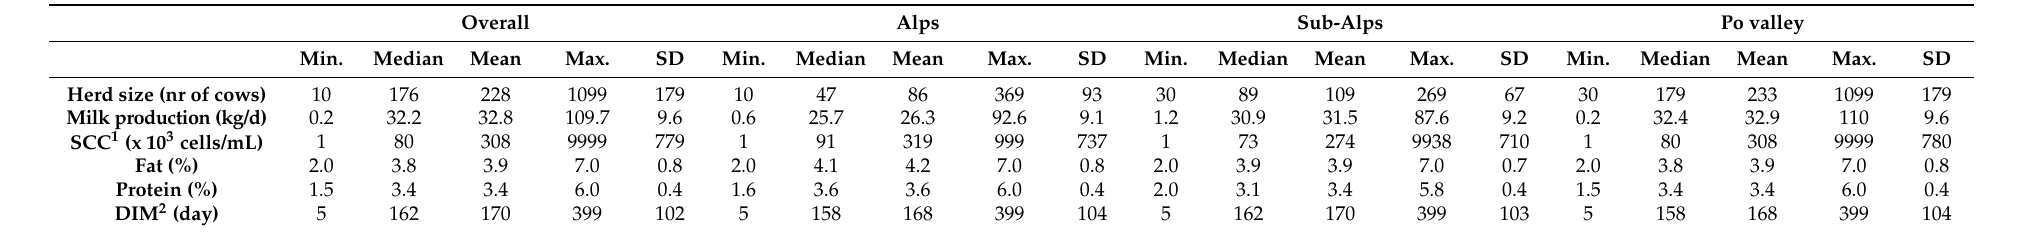
Table 3. Descriptive statistics of the final data (10,445,464 test-day records from 826,831 cows on 2970 herds in Lombardy, including 264,195 test-day records from the Alps, 108,287 test-day records from Sub-Alps and 10,072,982 test-day records from Po valley) at the test-day record